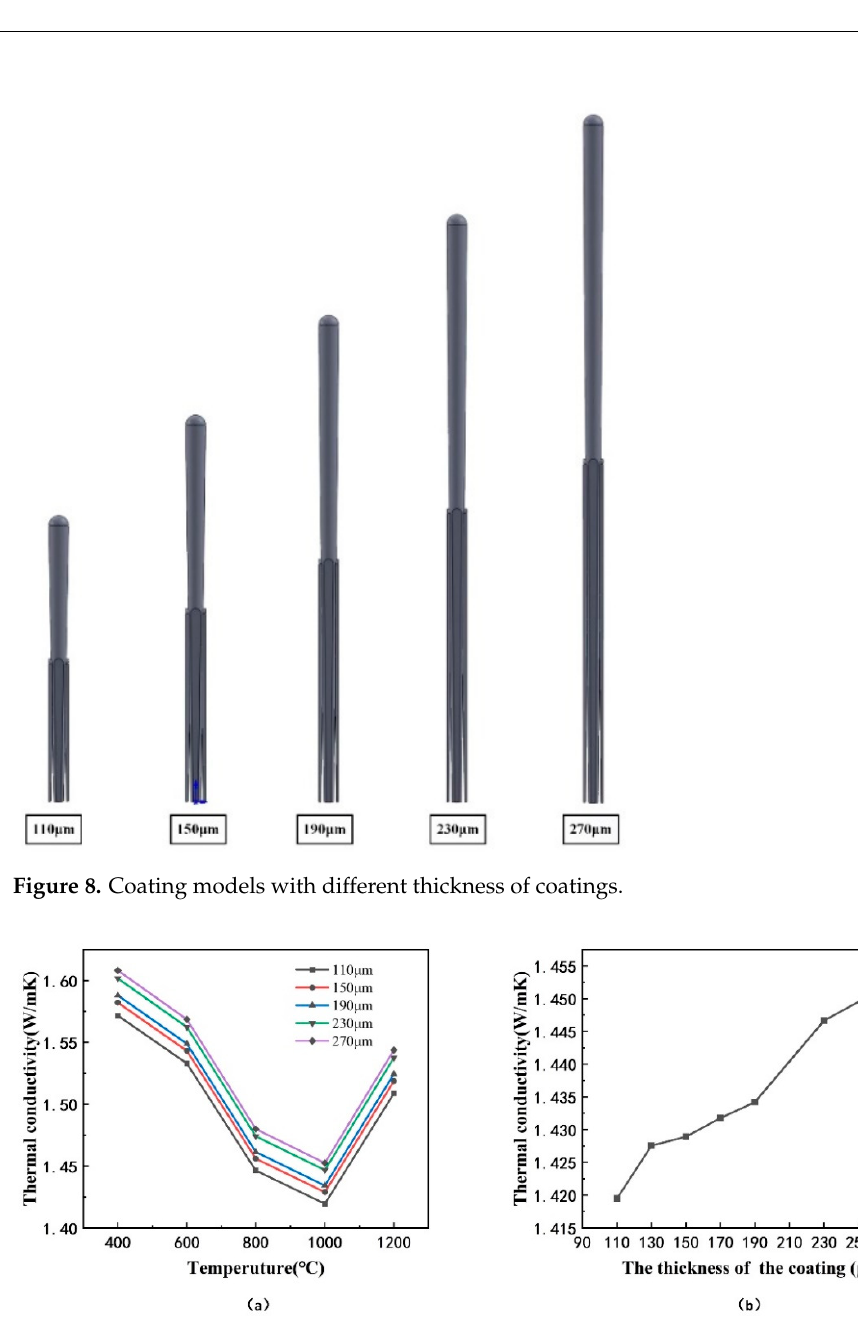
Figure 9. Effective thermal conductivity of models with different thickness of coatings: ( a ) at different levels of temperature, ( b ) at 1000 °C.